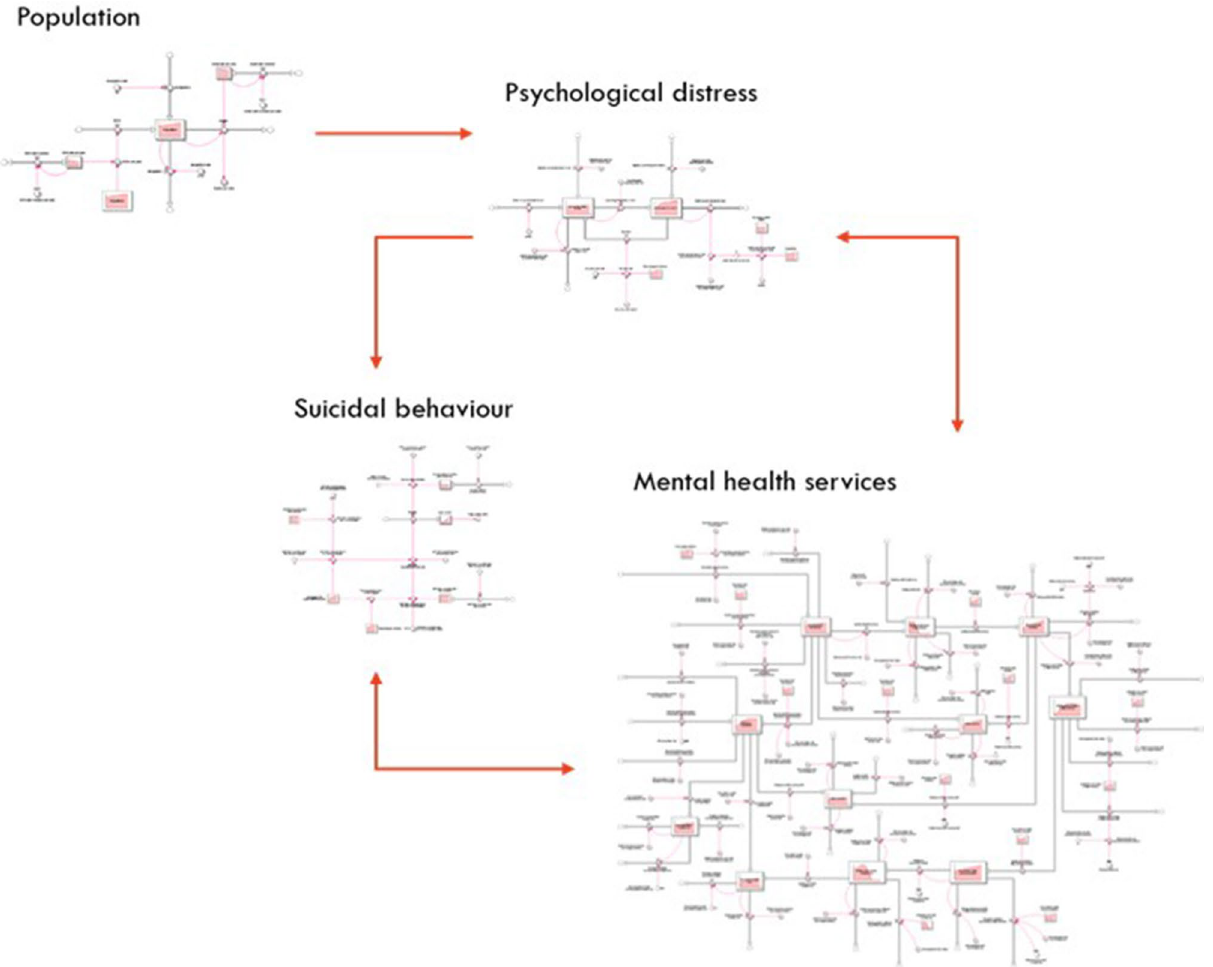
Figure 1. A high-level overview of the causal structure and pathways of the system dynamics